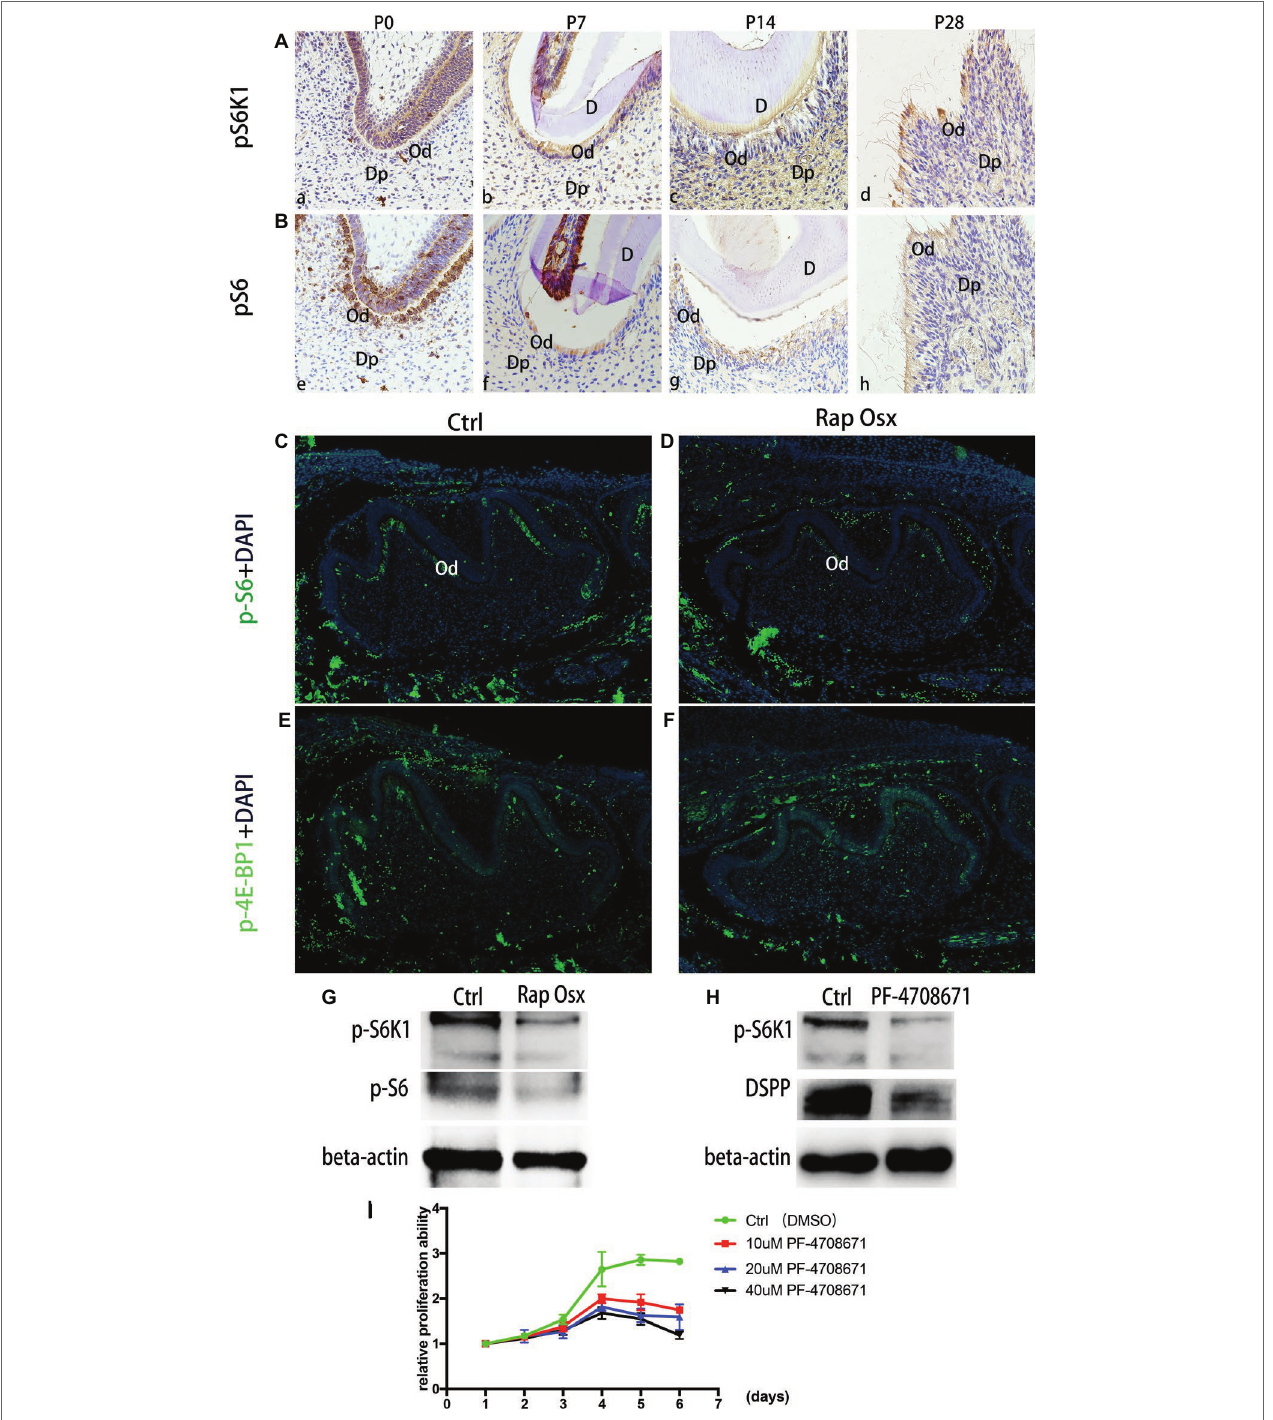
FIGURE 5 | Phosphorylation capacity of pS6K1 decreased after Raptor deficiency. (A) Detection of phosphorylation levels of pS6K1 in the mandibular first molar was performed by immunohistochemistry staining at P0 (a), P7 (b), P14 (c), and P28 (d). (B) Detection of the phosphorylation levels of pS6 in the mandibular first molar was performed at P0 (e), P7 (f), P14 (g), and P28 (h). (C,D) Detection of phosphorylated S6 in the mandibular first molar at P0. (E,F) Detection of phosphorylated 4E-BP1 in the mandibular first molar at P0. DP, dental pulp; OB, odontoblasts; D, dentin. (G) Protein expression levels of p-S6K1 and p-S6 in WT and mutant mice. (H) The DSPP expression level decreased by the S6K1 inhibitor. (I) PF-4708671 inhibited the proliferation of dental mesenchymal cells from WT